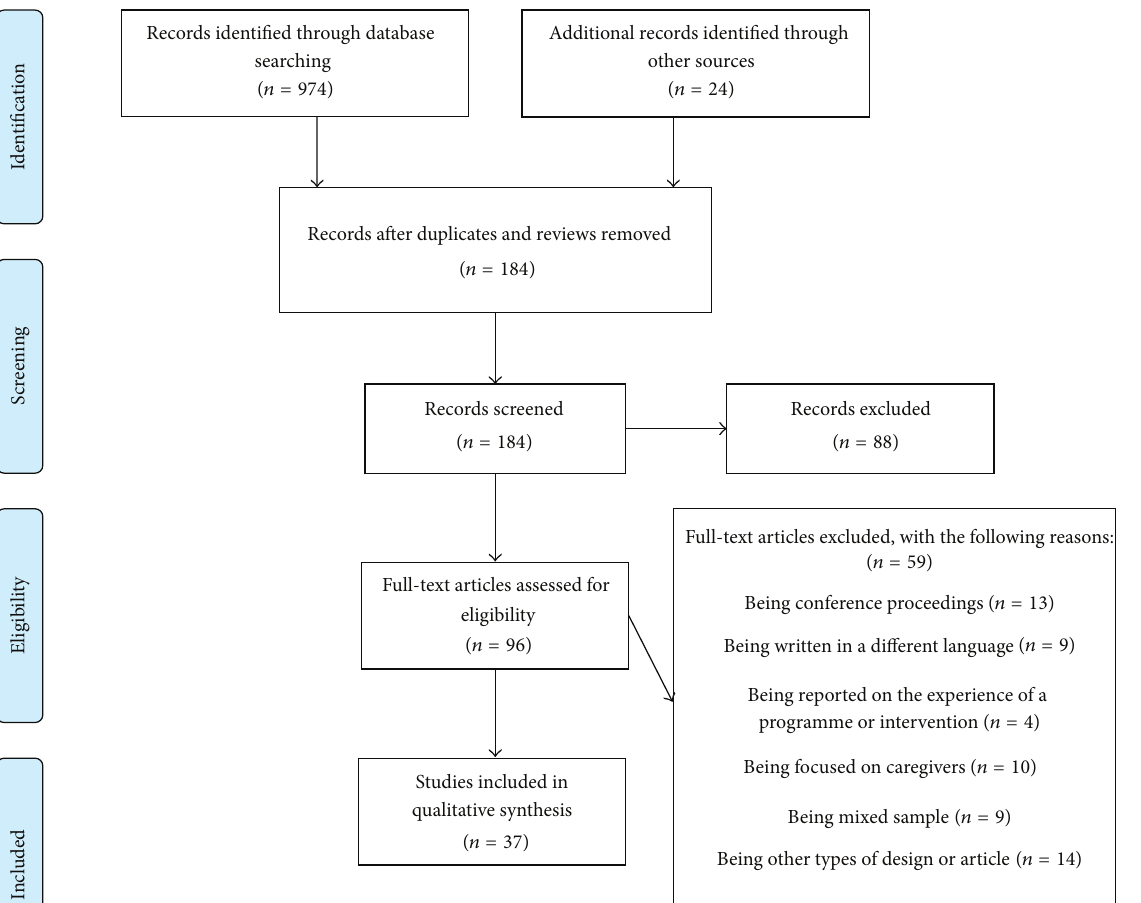
Figure 1: A PRISMA diagram for the